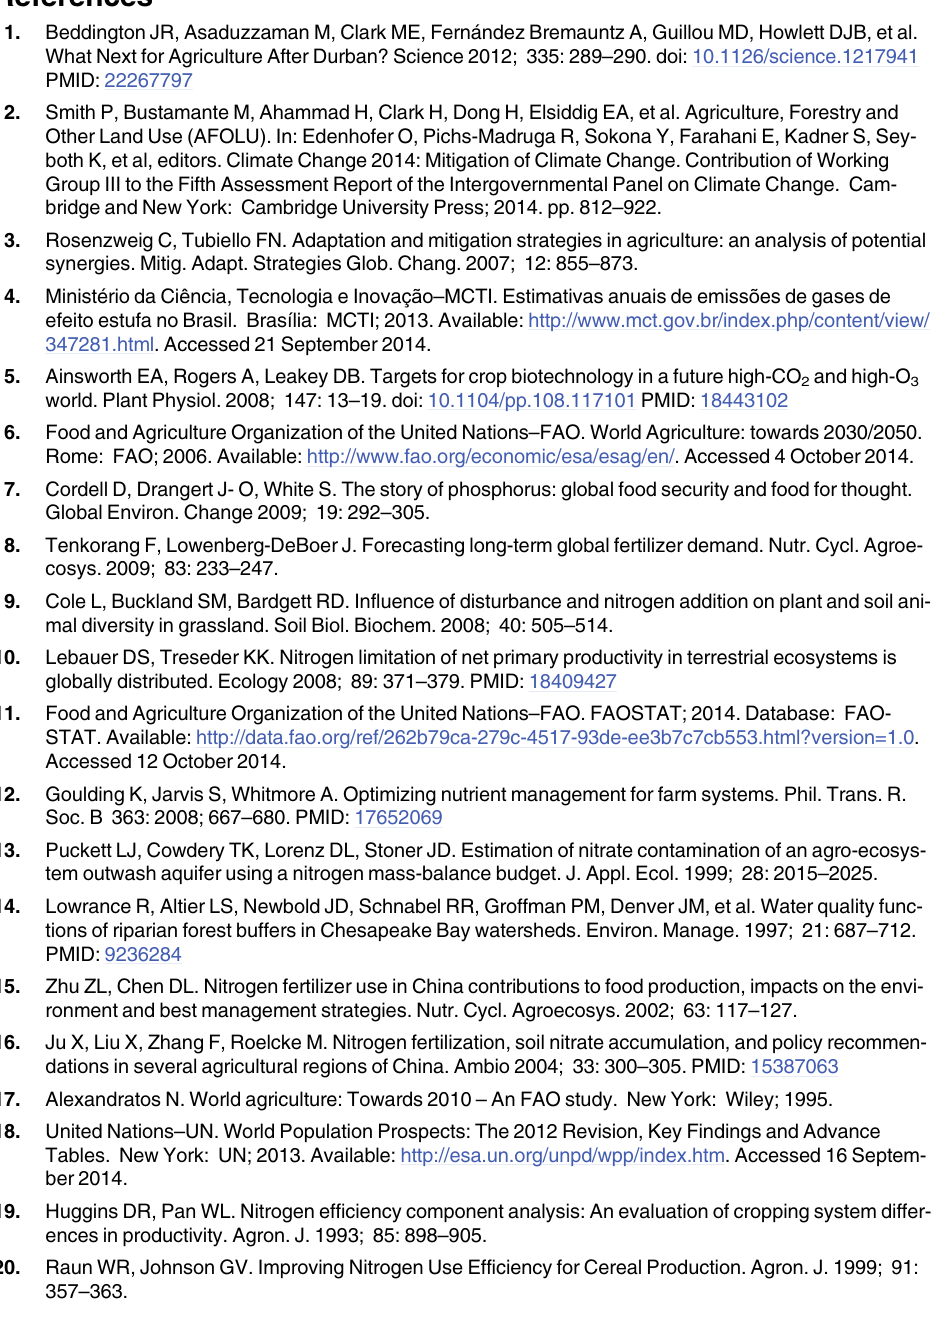
S6 Table. Effect of nitrogen fertilizer consumption on cereal yield for Brazil – Model fit.